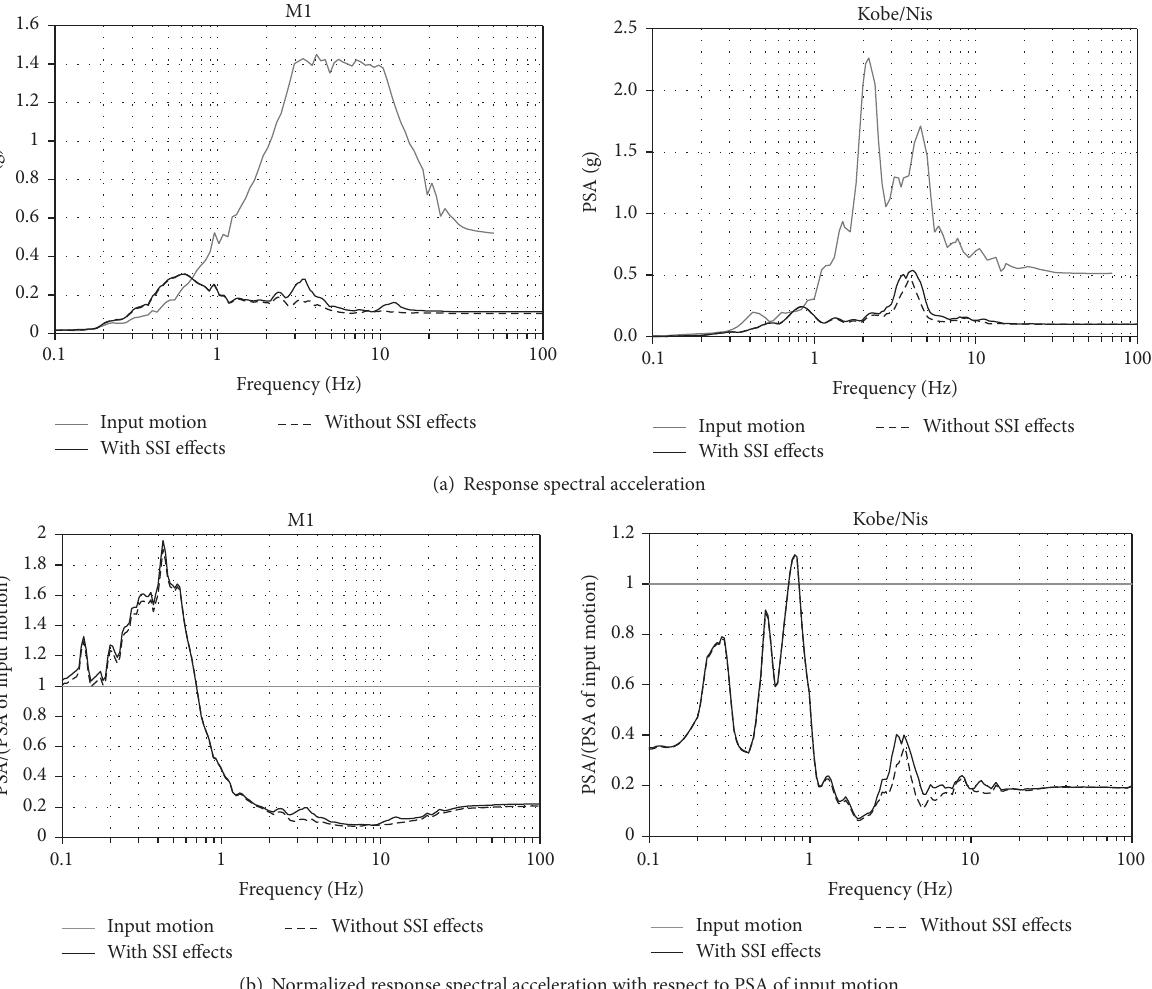
Figure 5: Comparison of the response spectral acceleration for the top of the Reactor Containment Building and input motion.